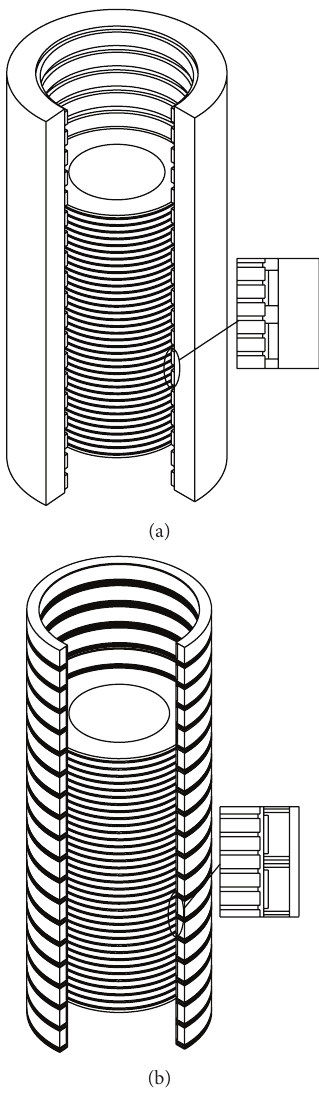
Figure 5: FEA model of TPMLWG: (a) the traditional surface TPMLWG and (b) the new secondary structure